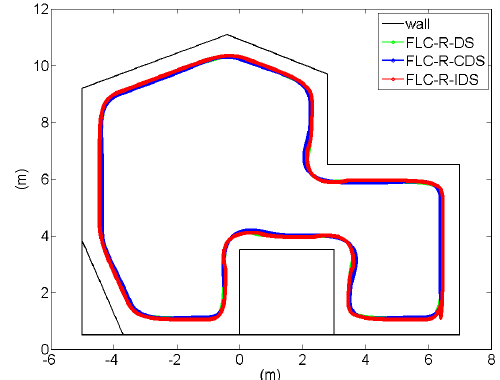
Figure 9. Comparison of the path tracking best performances of the proposed FLC_R-IDS, FLC_R-DS and the FLC_R-CDS methods in test environment 1. Table 4. Comparison of 30 controllers and their MAE values of various existing models in test environment 1.